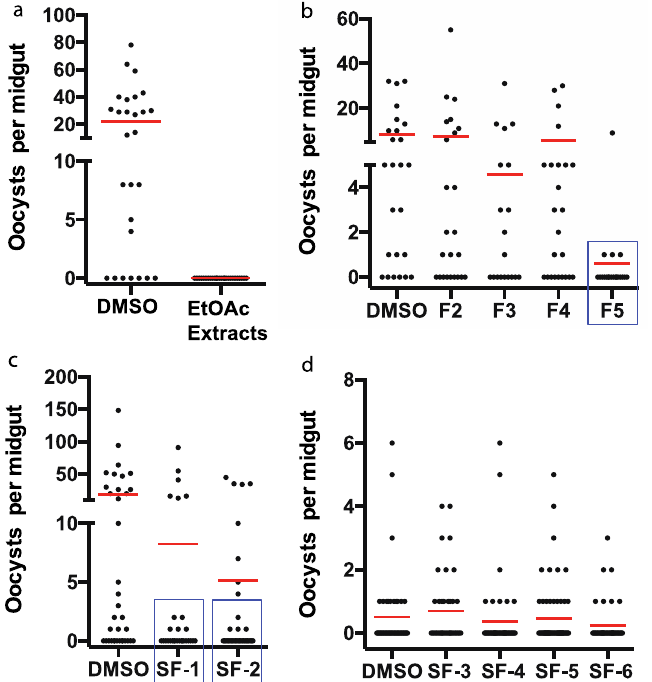
Figure 3. Inhibition of chromatography fractions. ( a , b ) or subfractions ( c , d ) of fungal extract on P. falciparum infection in An. gambiae was analyzed by SMFA. ( a , b ) activities of crude extract fractions through silica gel liquid chromatography. ( c , d ) activities of subfractions from active fraction F5 by a silica gel gravity column. concentration of samples is 30 µg/mL. p -value between control (DMSO) and a sample was calculated by Mann-Whitney test. Samples, highlighted by blue rectangles, significantly inhibited P. falciparum transmission to mosquitoes ( p < 0.05). Each experiment was conducted twice, and similar results were obtained.